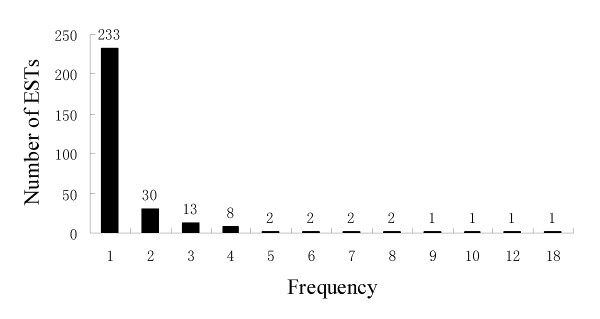
ESTs redundancy in the SSH library. Number of ESTs in each category is also presented at the top of each bar.